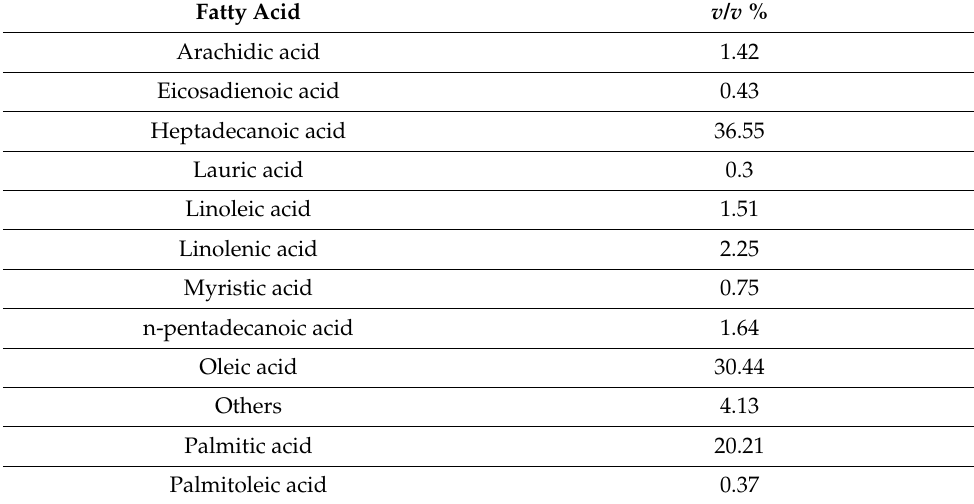
Table 2. Chemical composition of SFWCO.